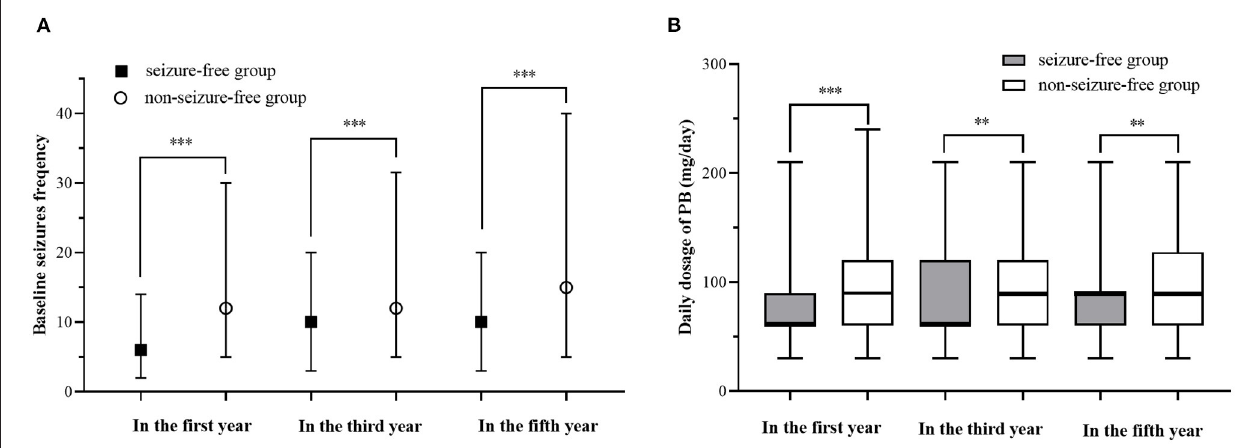
FIGURE 2 | Comparison of baseline Seizures frequency and daily dosage in the first year between different prognosis. (A) Comparison of baseline Seizures frequency of different prognosis. (B) Comparison of baseline Seizures frequency of different prognosis. “**” indicates a statistical significance ( P < 0.01) between seizure-free group and non-seizure-free group, “***” indicates a statistical significance ( P < 0.001) between seizure-free group and non-seizure-free group.